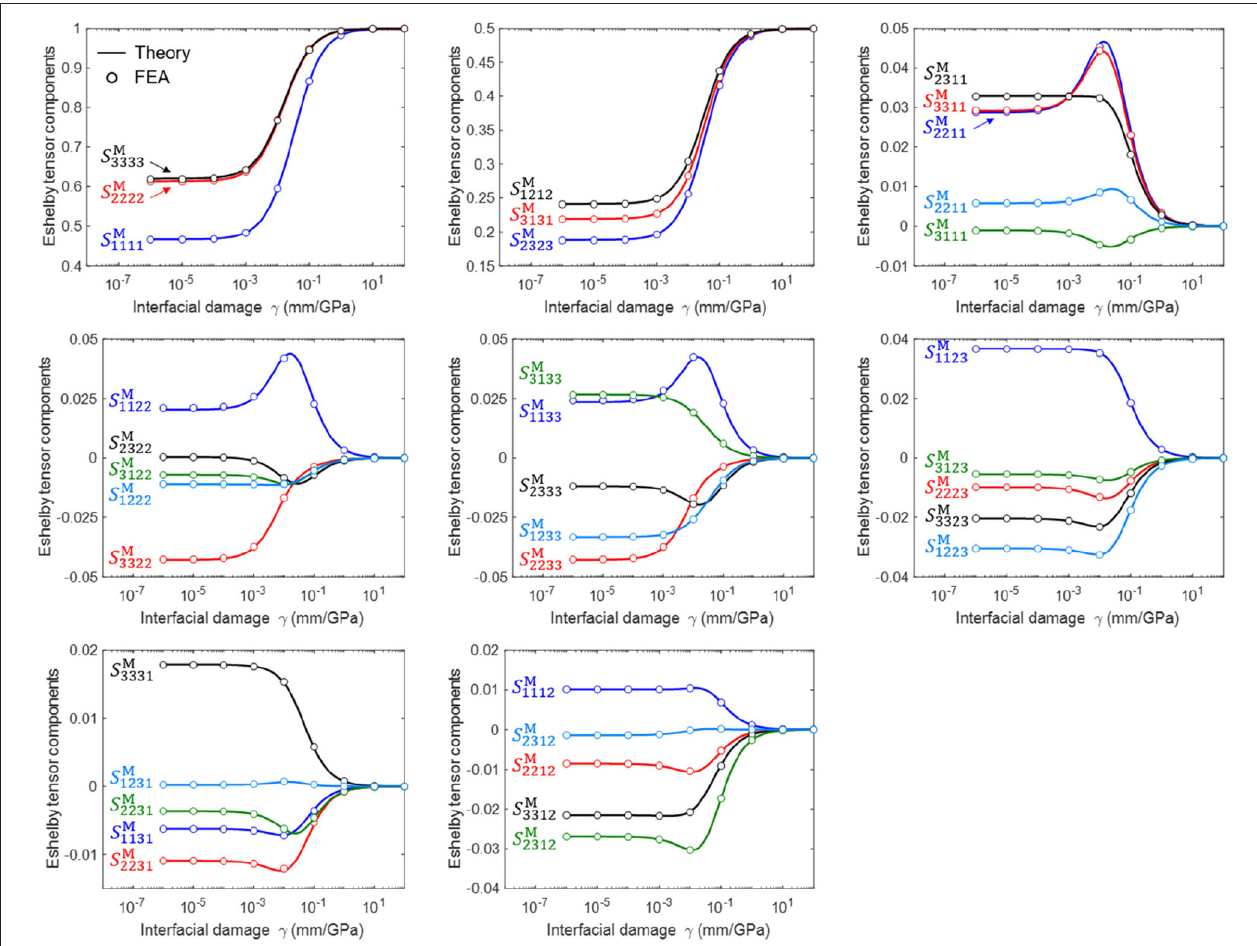
FIGURE 5 | Thirty-six independent components of a modified Eshelby tensor for a wide range of interfacial damage. The triclinic material used for this calculation is NaAlSi 3 O 8 ( Lee et al.,